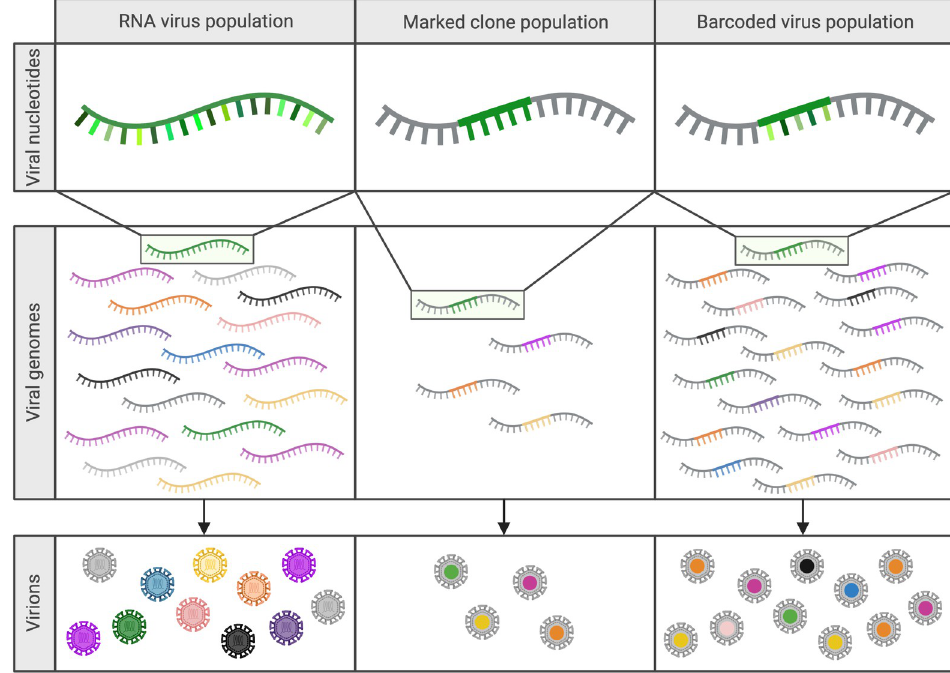
Fig 1. Barcoded viruses are highly effective mimics of RNA virus mutant swarms. Marked clones and barcoded viruses allow investigators to study changes to population diversity in a variety of systems without the variable fitness observed between viruses in natural RNA virus swarms. (Created with